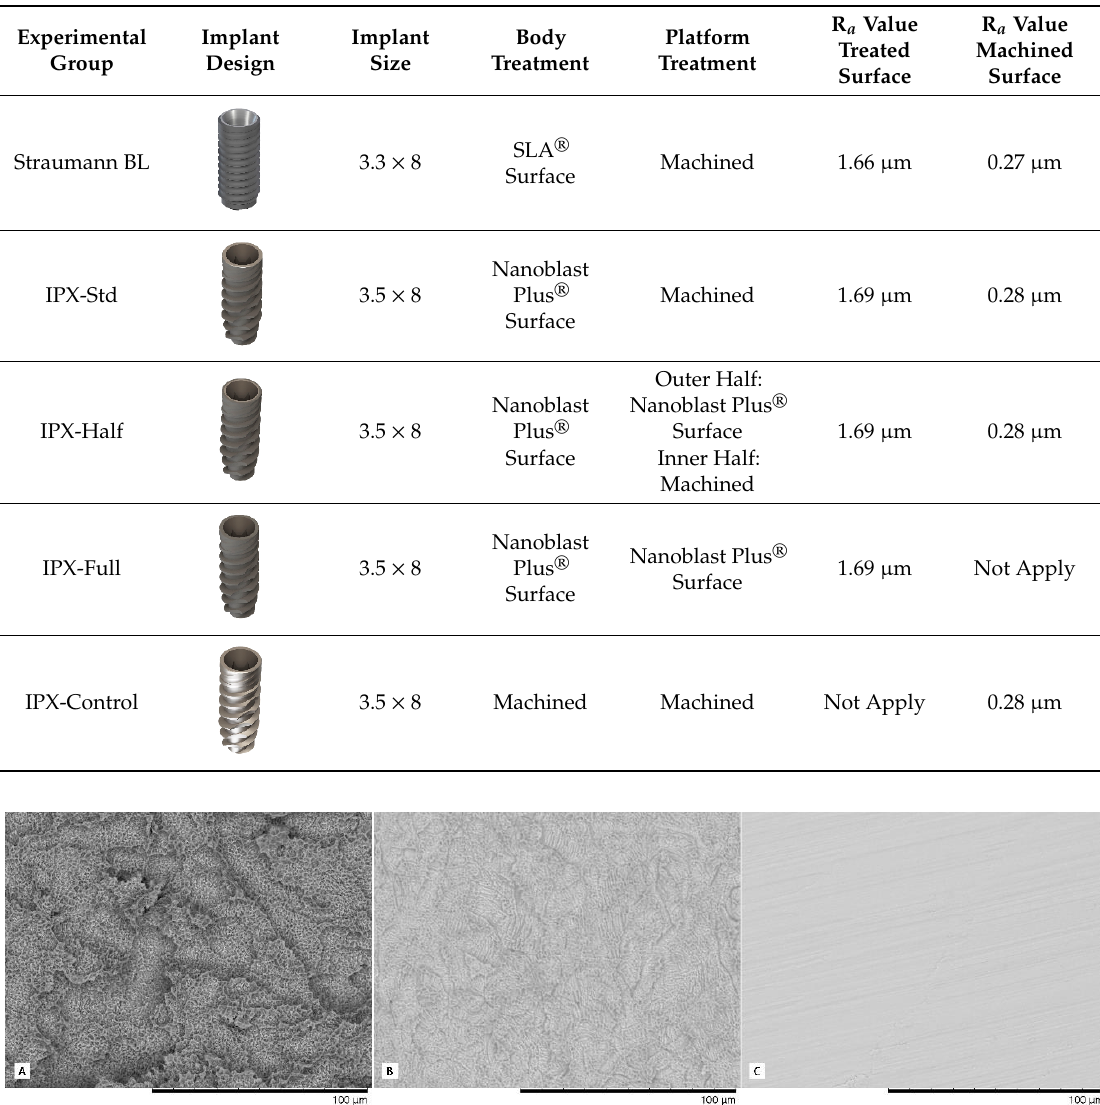
Table 1. Summary of the main characteristics of each experimental group, including implant design, implant size, body treatment, platform treatment, and R a values (mean and standard deviation) for both treated and machined surfaces.